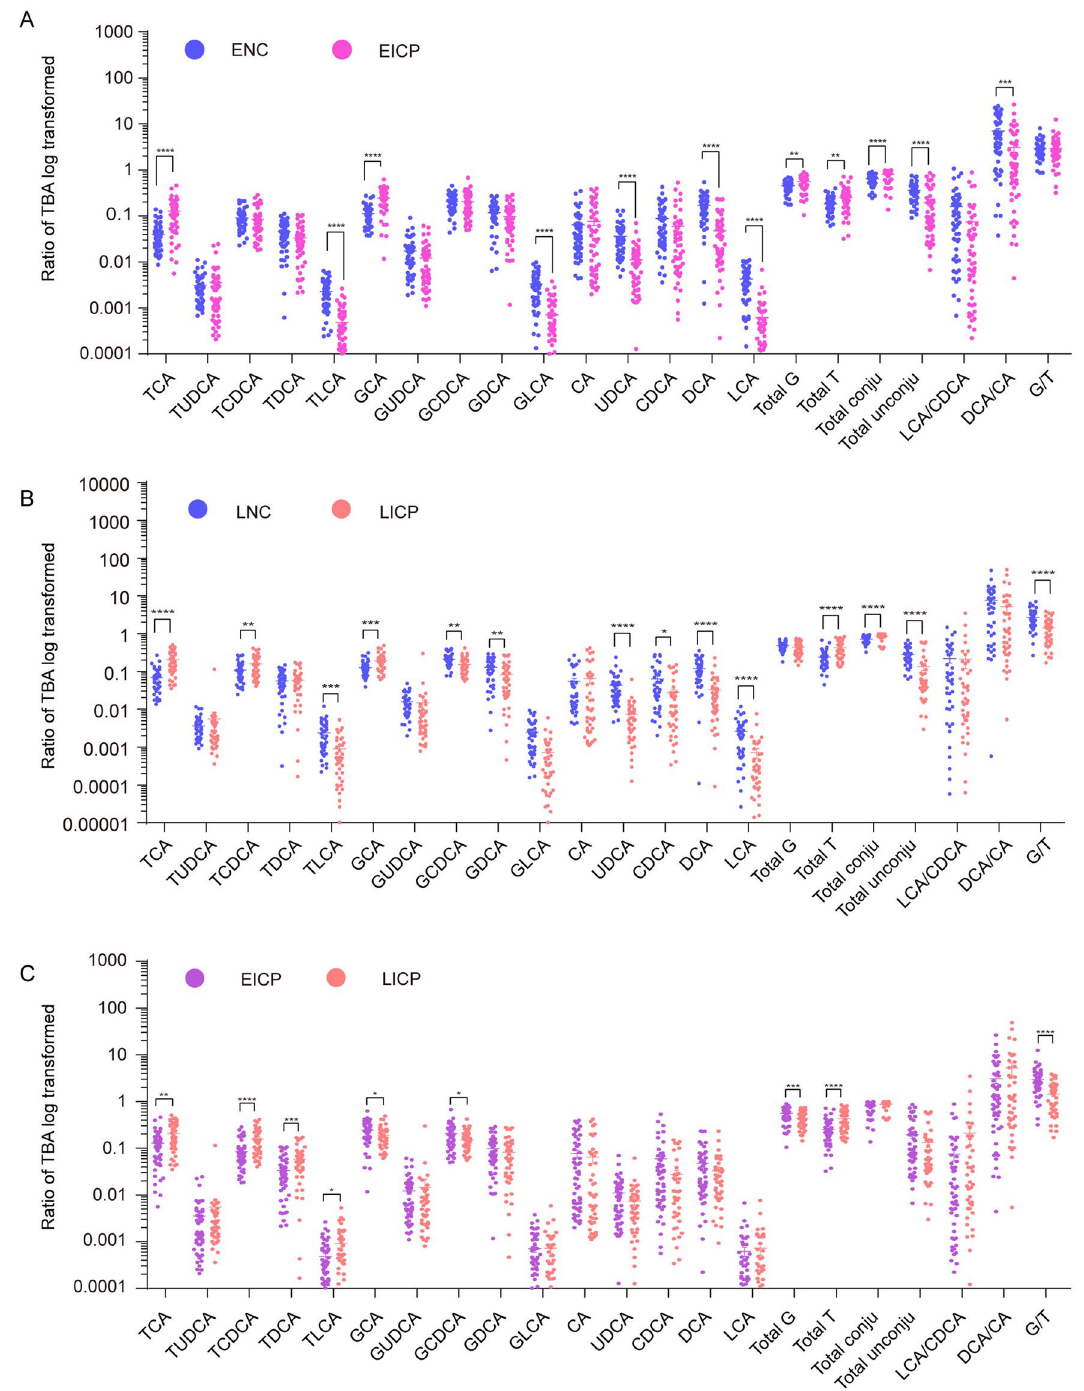
Figure 4. Changes in BA metabolism profiles in EICP ( A ) and LICP ( B ) compared with normal pregnant women. Different BA metabolism profiles between EICP and LICP ( C ), BAs are represented as the percentage of TBA and log transformed. * P < 0.05; ** P < 0.01; *** P < 0.001; **** P <